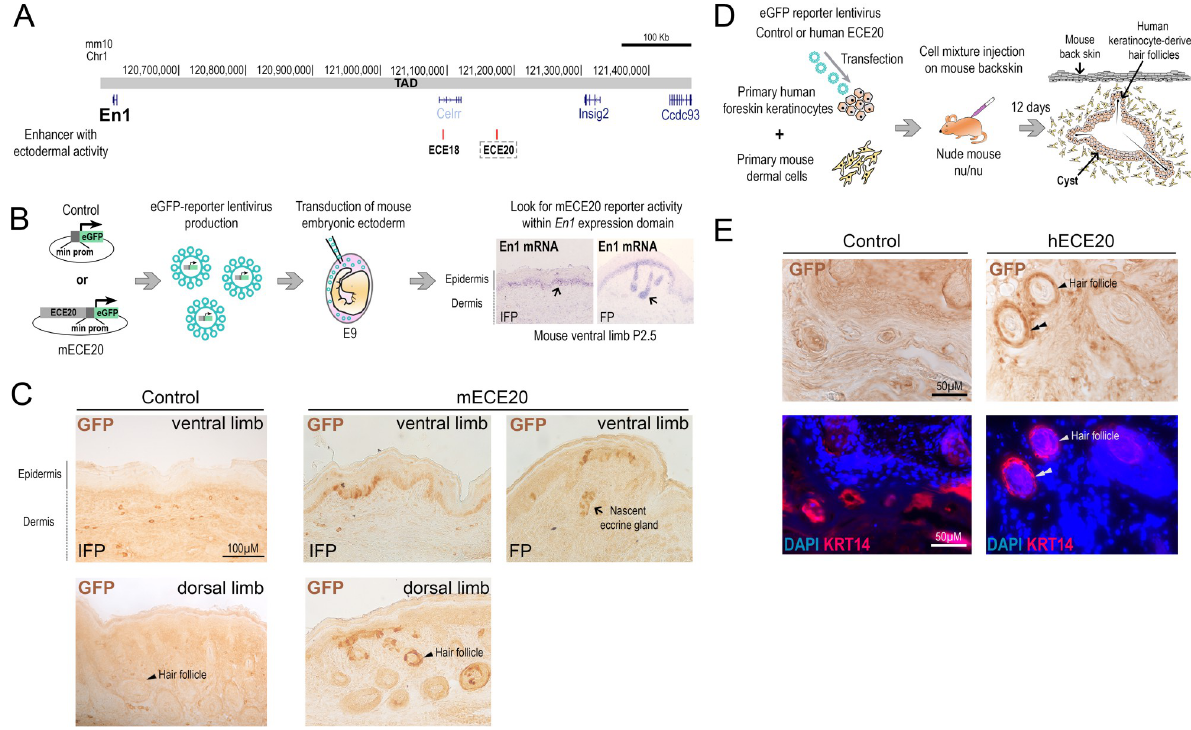
Fig 1. ECE20 is a developmental enhancer active in basal ectoderm. (A) Genomic locations of En1 candidate enhancers (ECEs) ECE18 and ECE20 (boxed) in the mouse genome (mm10). En1 Topological associating domain (TAD). (B) Strategy used to generate skin-specific transgenic mice to assess spatial and temporal activity of mouse ECE20 homolog (mECE20) in vivo . In situ hybridization for En1 mRNA (purple) in mouse volar limb skin at P2.5. Representative images of volar skin from the interfootpad (IFP) medial volar skin and footpad (FP) volar skin are shown. Nascent eccrine gland (black arrow). (C) Representative images of control and mECE20 transgenic P2.5 volar and dorsal limb autopods stained with anti-GFP antibody. eGFP is visualized using HRP-DAB-coupled immunohistochemistry so signal is brown. Nascent volar eccrine gland (black arrow). Dorsal hair follicle (head arrow). (D) Strategy to reconstitute transgenic human-derived developing ectoderm in hybrid human-mouse skin patches to test spatial and temporal activity of human ECE20 (hECE20) in vivo . (E) Representative images of a section from human developing skin infected with hECE20 or control virus and stained with antibody against GFP (brown) and also stained with the basal keratinocyte specific marker Keratin 14 (KRT14, Red). eGFP (black double head arrow) is visualized using HRP-DAB coupled immunohistochemistry so positive clones are brown. Primary human basal keratinocyte cells double positive for GFP and KRT14 (white double head arrow). DAPI nuclear stain (blue). See also S1